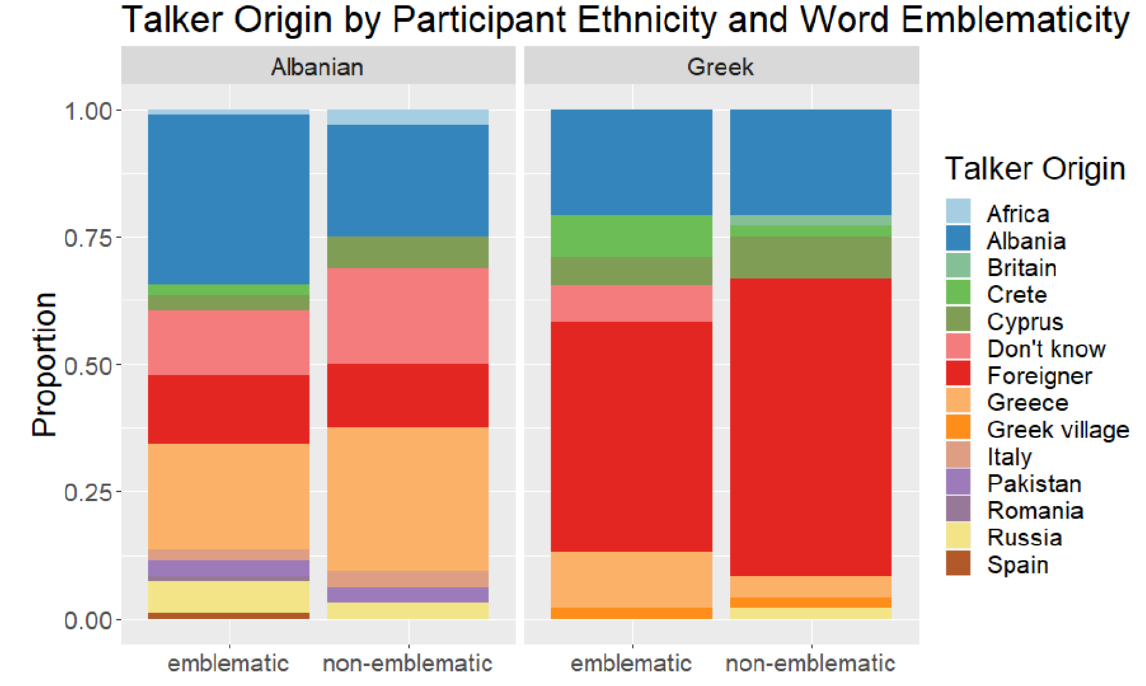
Figure 1. Proportions of listeners identified the talker’s origin by participant ethnicity and target word emblematicity type.